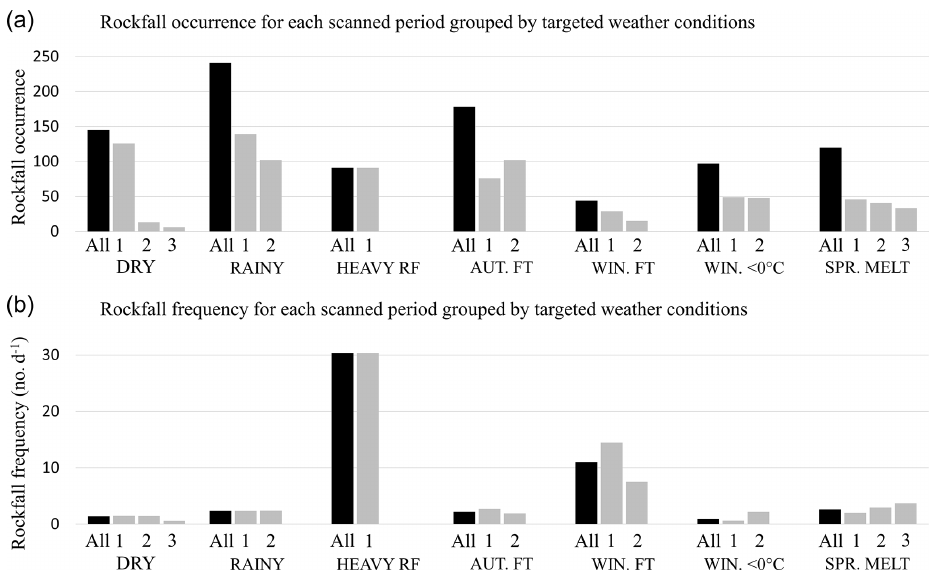
Figure 8. Rockfall occurrence (a) and frequency (b) for each scanned survey period, grouped by targeted weather conditions for all